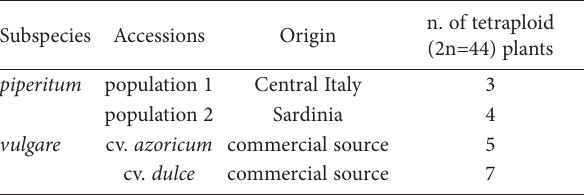
Table 1. List of accessions of F. vulgare subspp. piperitum and vul- gare examined and number of tetraploid (2n=44) plants